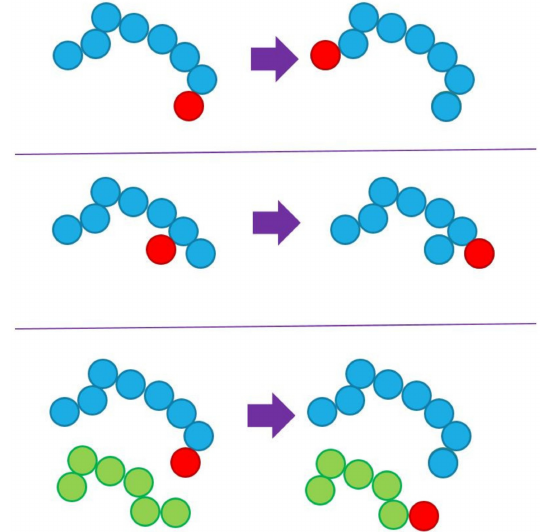
Figure 3. Schematic representation of ( top ) IdEx1 involving a chain and a single monomer within a bridgeable distance from a chain end, ( middle ) IdEx2 involving a chain and a single monomer within a bridgeable distance from the atom lying in the second of penultimate position in the chain, and ( bottom ) IdEx3, which includes a pair of chains and a single monomer. In IdEx3, the single monomer, lying within a bridgeable distance from an end of the blue chain becomes part of it, while a randomly selected chain (shown here in green) loses a randomly selected end, which becomes a single monomer. None of the moves depicted above include the displacement of atoms, rather only deletion and formation of bonds. IdEx3 requires dispersity in chain lengths in order to be applicable. In all cases, chain monomers are shown in blue (or green) and single monomers in